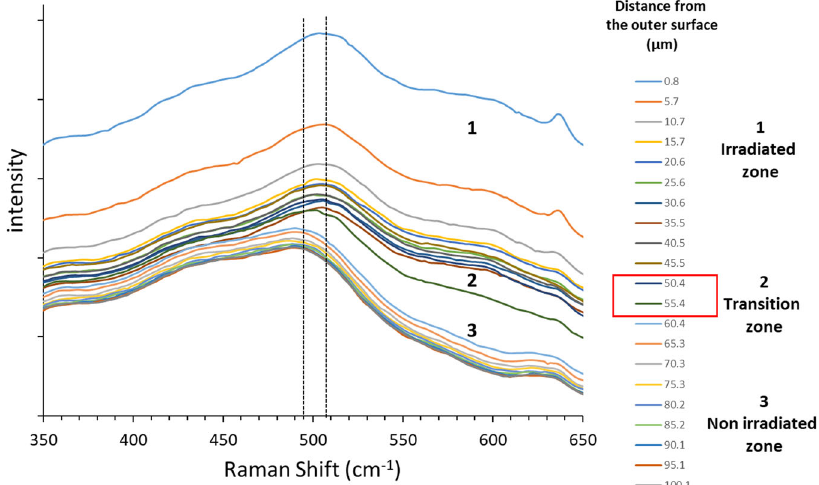
Fig. 2 Raman shift of the R-band depending on the depth, for the pre-irradiated